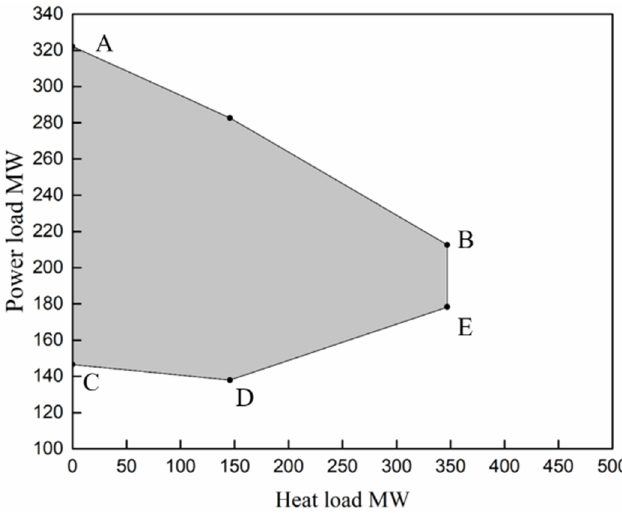
Figure 5. Operation region of #1